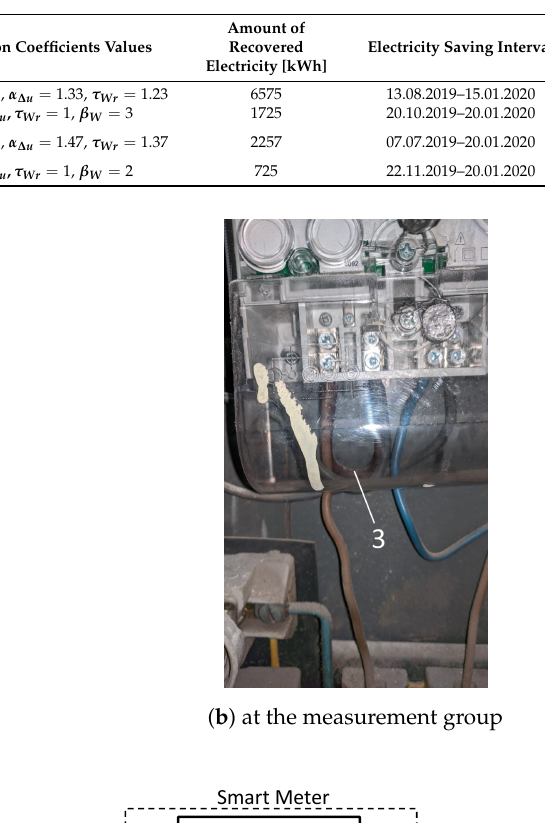
Table 4. Results analysis.